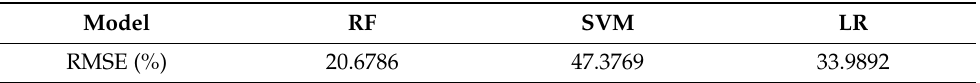
Table 7. Comparison of evaluation results of CMDRI under different